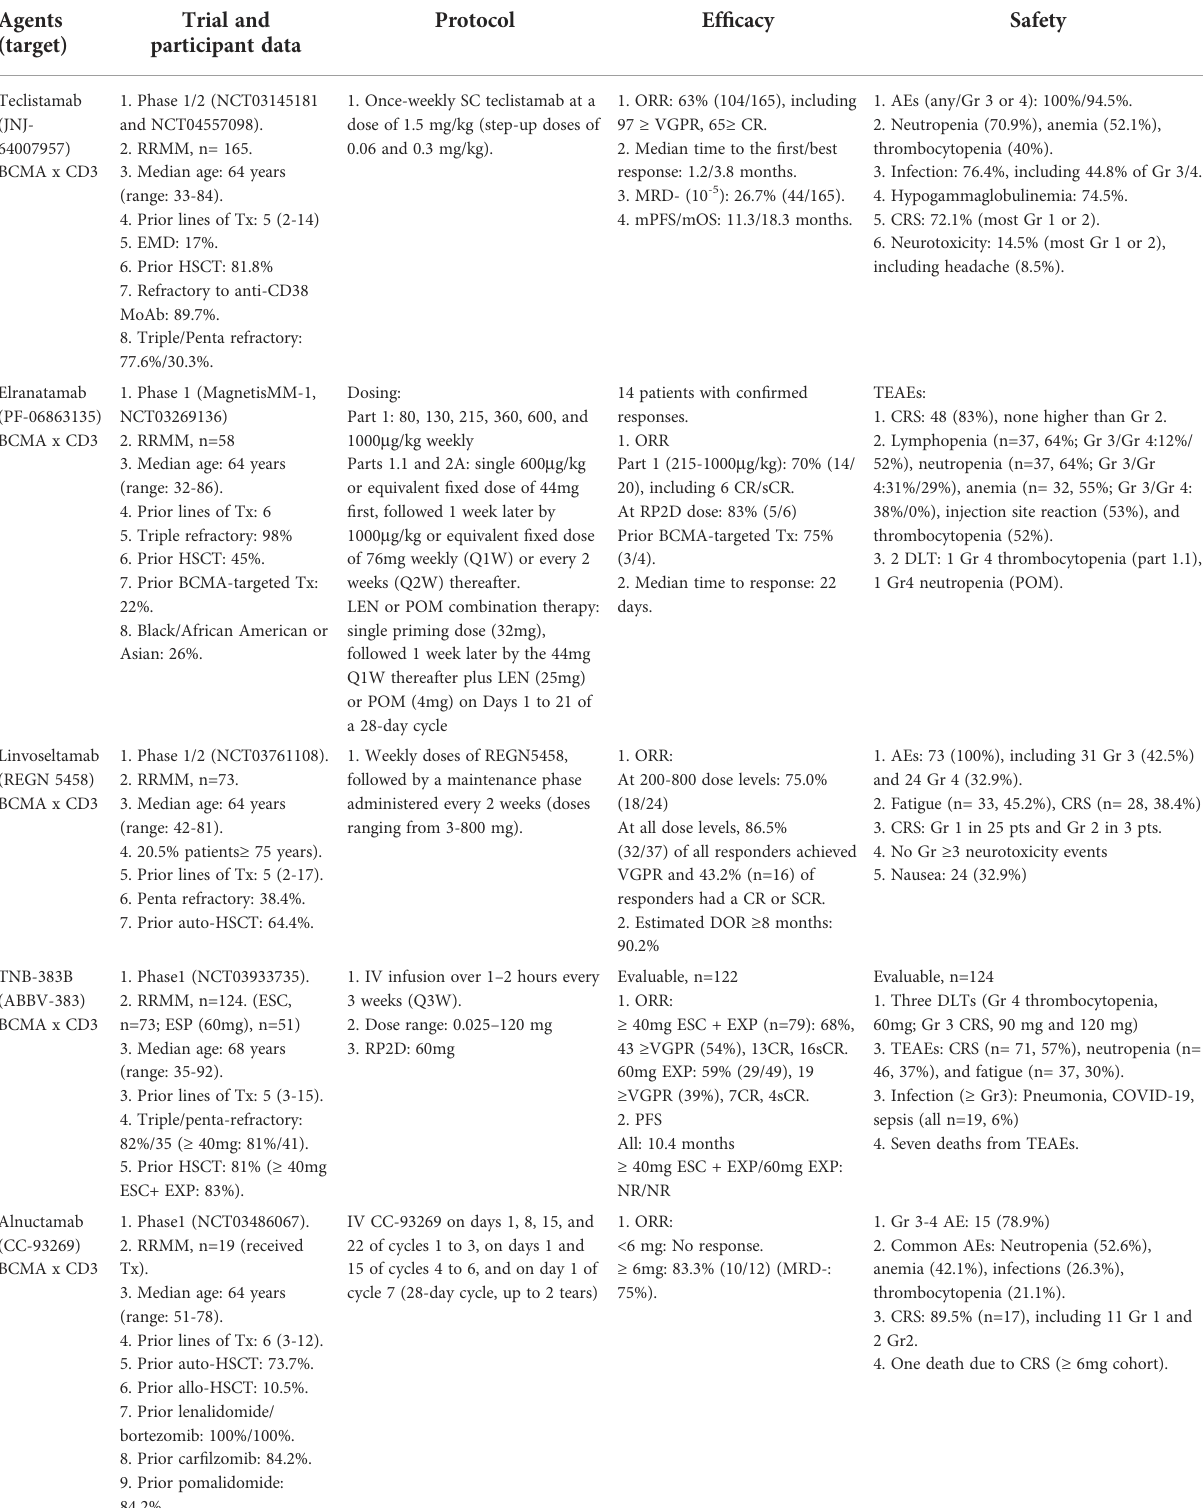
TABLE 1 Summary of clinical trials of BiTE/BiAb